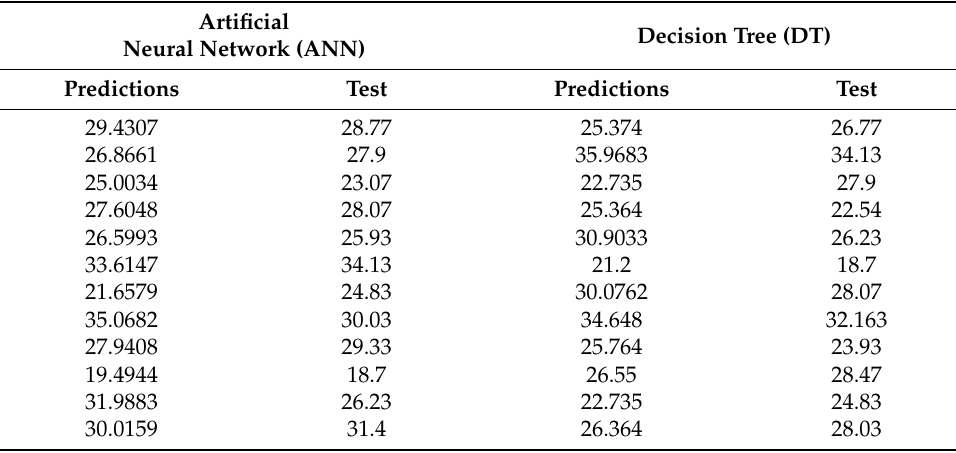
Table A2. Actual and predicted values of the ANN and DT